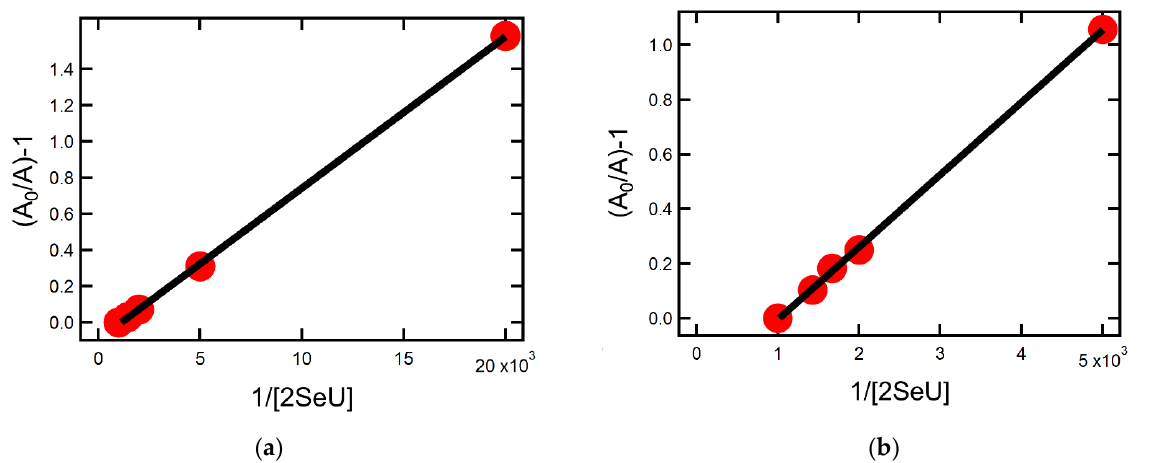
Figure 8. Dependence of the term A 0 / A − 1 at λ = 440 nm on the reciprocal of 2-SeU concentration in the pulse radiolysis of N 2 O-saturated unbuffered aqueous solutions containing 30 mM of NaN 3 at pH = 6 ( a ), and pH 10 ( b ) .